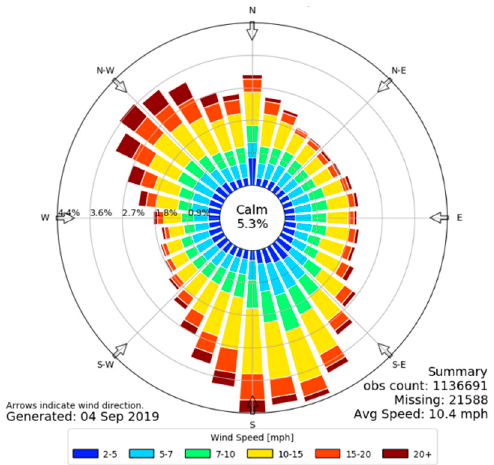
Figure 15. Wind rose measured at an airport for 25 years, about 14 miles SW of the wind farm. Data obtained from Iowa State University, Iowa Environmental Mesonet [39]. The length of the bars indicates the frequency in percentage units.